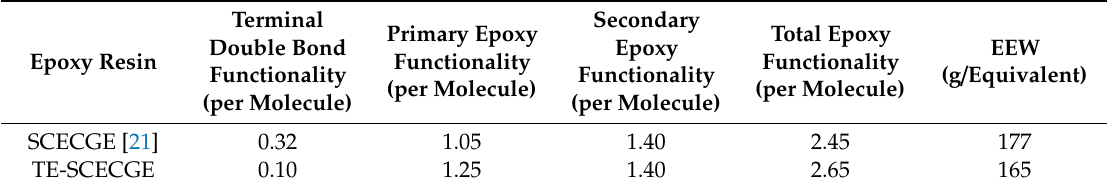
Table 1. Epoxy content of the side chain epoxidized cardanol glycidyl ether (SCECGE) and TE-SCEGE